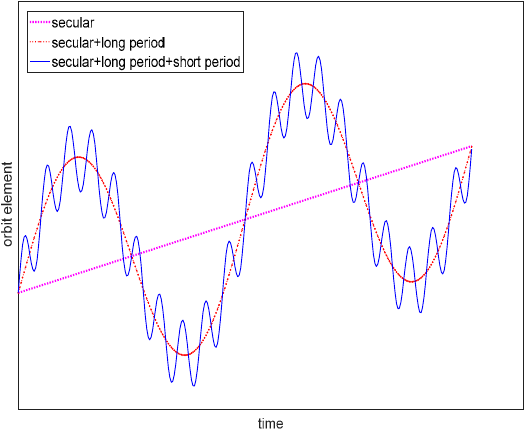
Figure 2. Variations of the orbital elements.